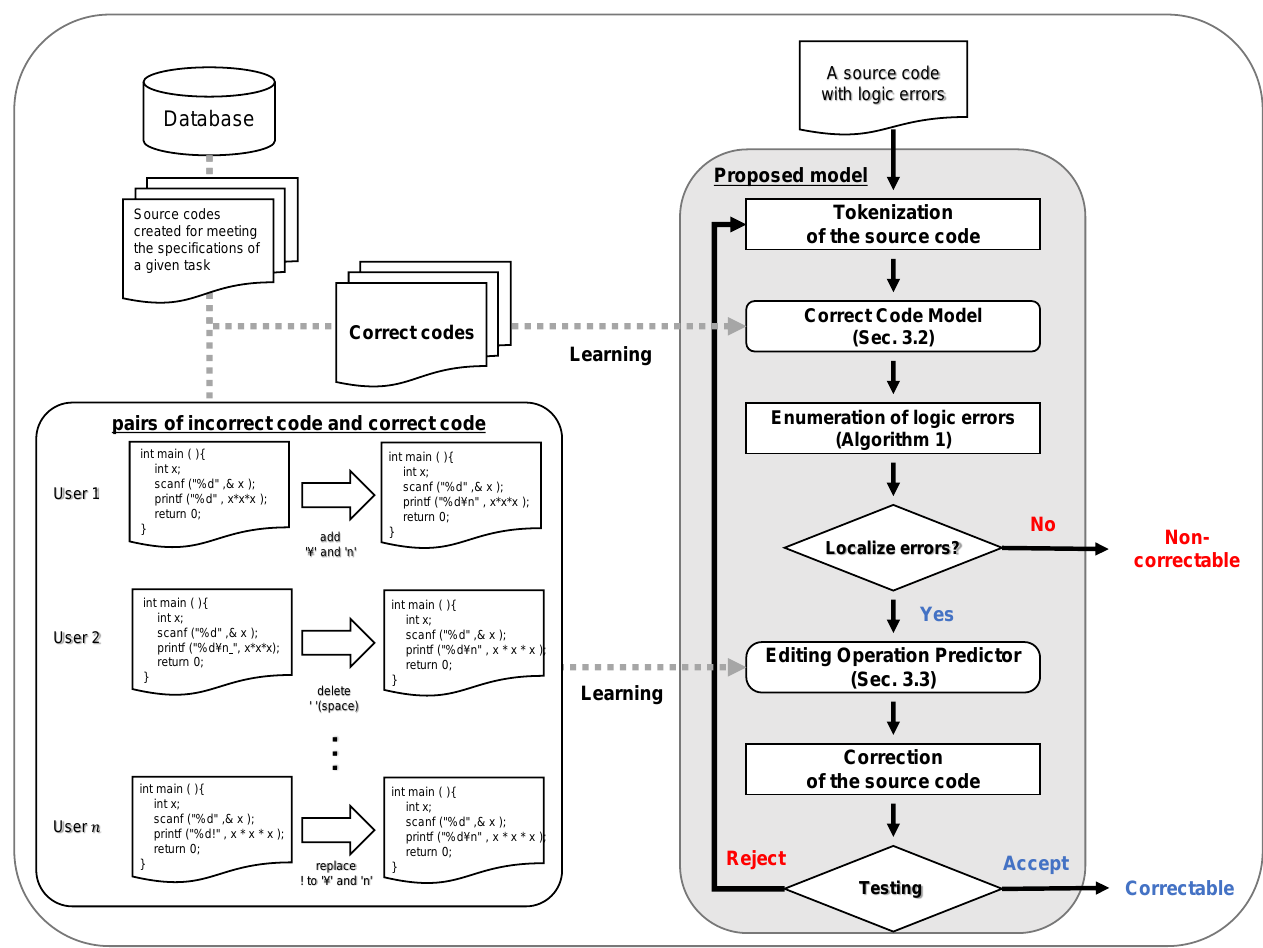
Figure 1. Overview of the proposed